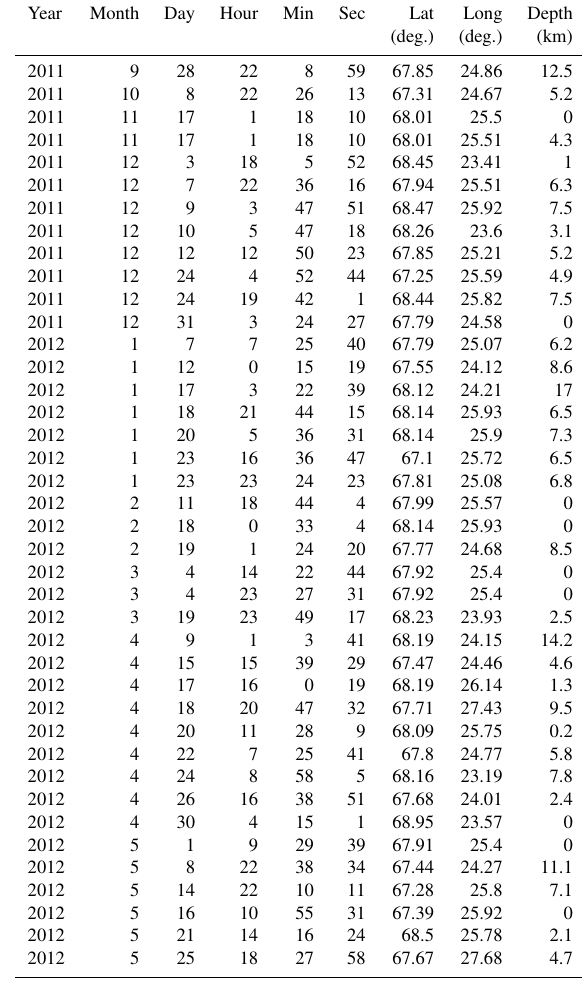
Table 2. List of seismic events in the area of Suasselkä postglacial fault detected by the DAFNE seismic